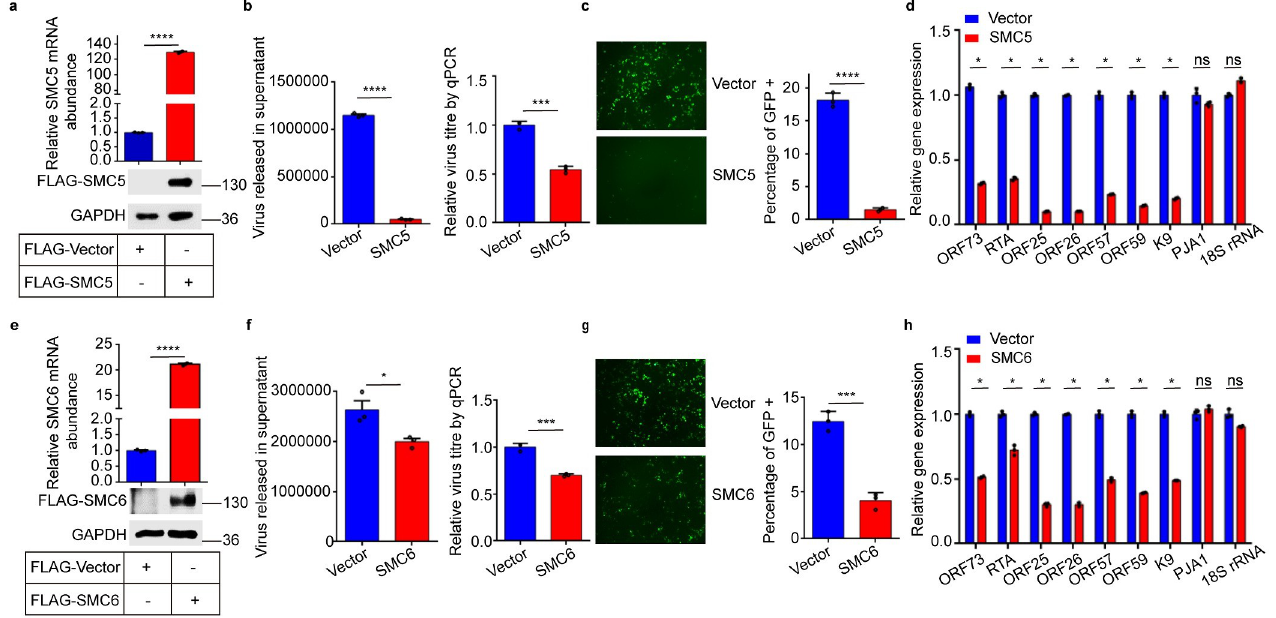
Fig 1. Ectopic expression of SMC5 and SMC6 inhibits KSHV lytic replication. (a) The expression of SMC5 was evaluated via qPCR and immunoblot. (b) DNase-treated extracellular viral loads of SMC5 were quantified via qPCR. Left panel, DNA copy numbers of extracellular viruses were quantified by using K9 primers. Right panel, after DNase treatment, pGL3-luc plasmid DNA was added during viral DNAs extraction to ensure the quality of DNA extraction. Relative DNA copy numbers were measured via qPCR using primers for K9 and pGL3. The values of control were set as 1. (c) Cell supernatants of SMC5-overexpressing cells were collected and infected with HEK293T cells. 24h later, KSHV-infected GFP-positive cells were observed by fluorescence microscope and analyzed by flow cytometry. (d) Viral genes and cellular genes expression were analyzed via qPCR. (e-h) Effect of SMC6 on KSHV lytic replication, which is similar to (a-d). Representative results from three biological replicates are presented. Error bars indicate SD. Data were analyzed with Student’s multiple t tests ( � p < 0.05, ��� p < 0.001, ���� p < 0.0001).